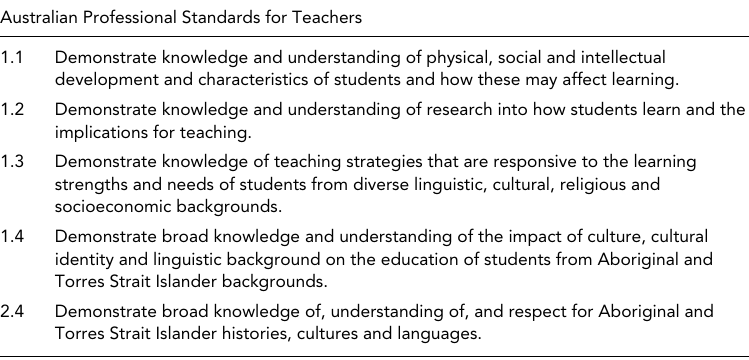
Excerpt From the Australian Professional Standards for Teachers Australian Professional Standards for